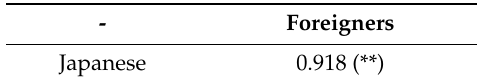
Table 5. Correlation coefficient between Japanese and foreign nationals associated with rating scales excluding oppressive feeling. (**: p < 0.01).